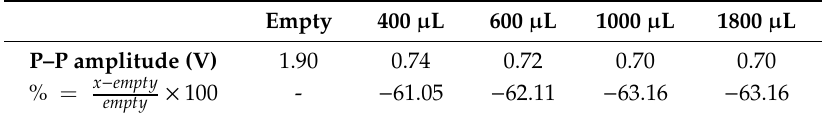
Table 3. The percentage drop in the peak ‐ to ‐ peak amplitude of the reflected wave from the edge for all cases.